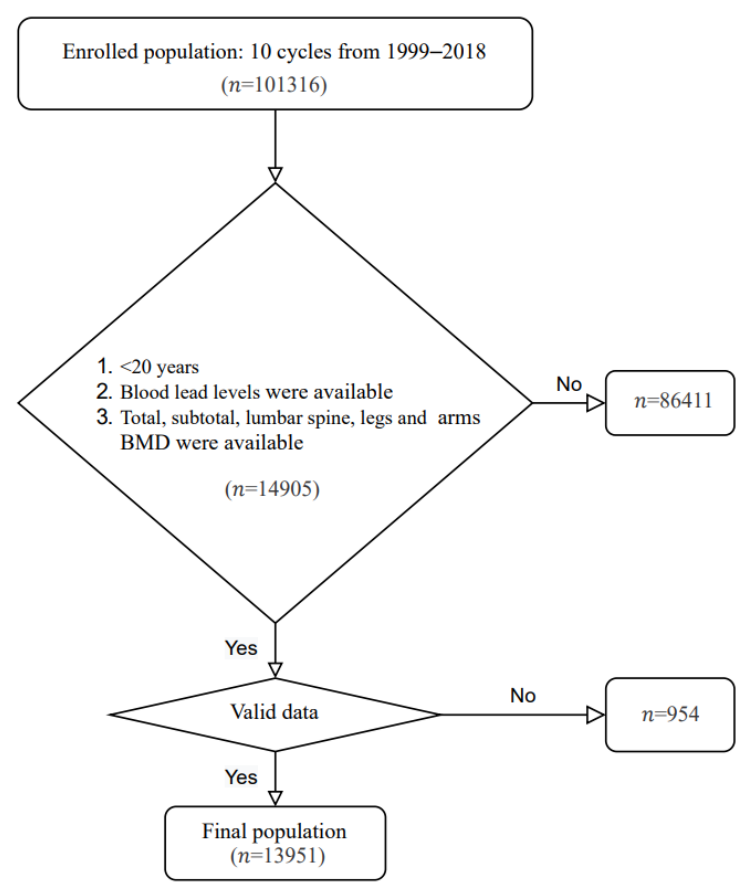
Figure 1. Flow chart of participants from NHANES included in the study. BMD, bone mineral density.